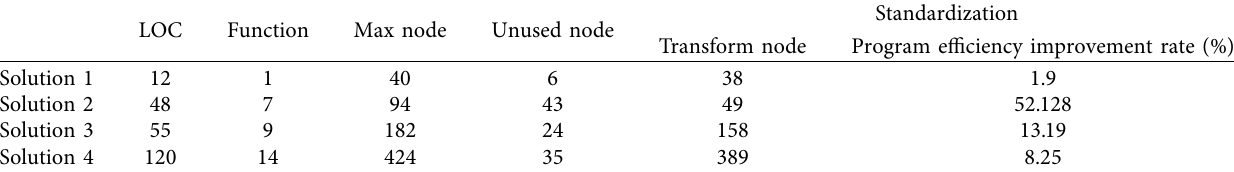
Table 7: General testing solution program condition.